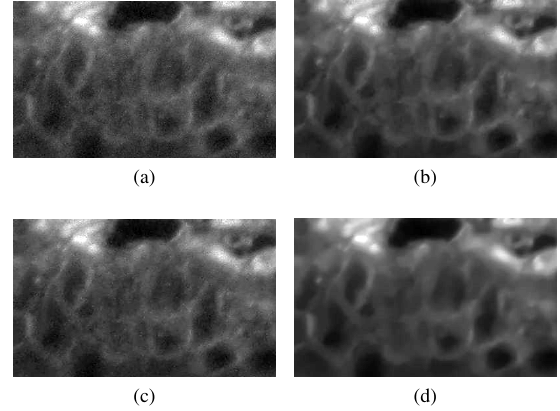
Figure 4. Results of a pemphigus vulgaris microscopy image denoising. (a) original image, (b) denoising result with optimal parameter, (c) denoising result with low parameter, (d) denoising result with high